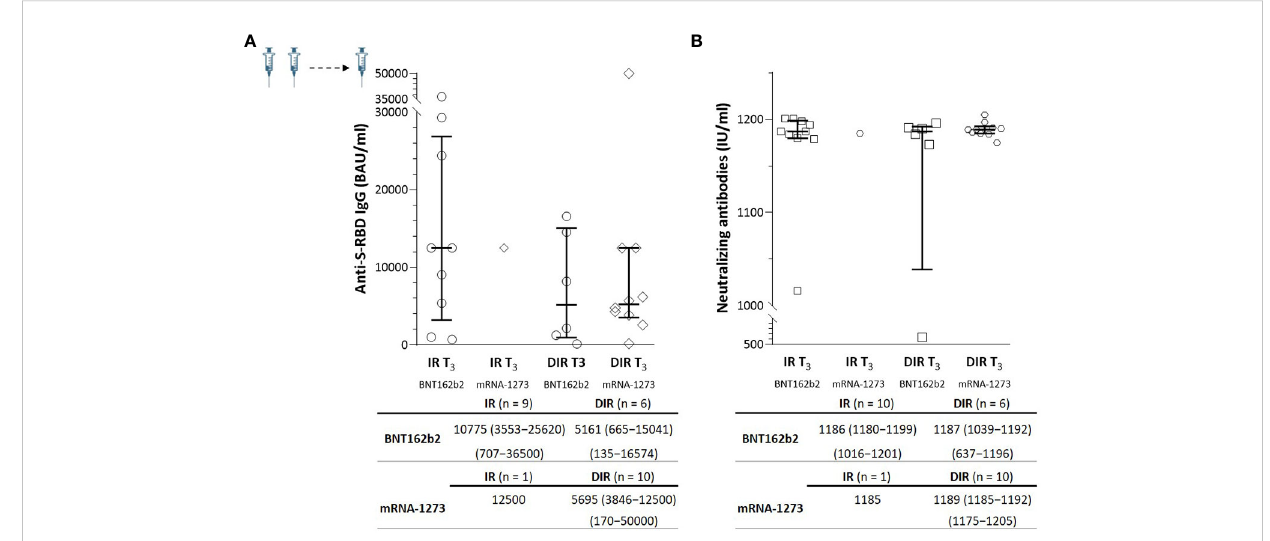
FIGURE 4 (A) Anti-S-RBD IgG and (B) neutralizing antibody titers one month (T3) after the third mRNA vaccine dose according to the group of participants (IR, immune responders. DIR, discordant immune responders) and the vaccine received.